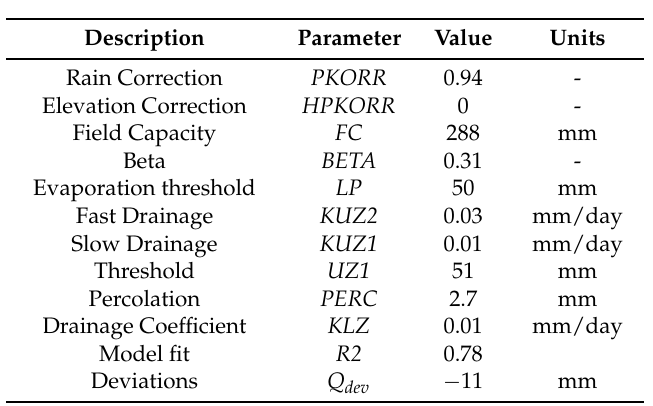
Table 6. HBV calibration parameters for Zambezi River at Victoria Falls. Dev. denotes the difference in observed total runoff and the simulated runoff during the calibration